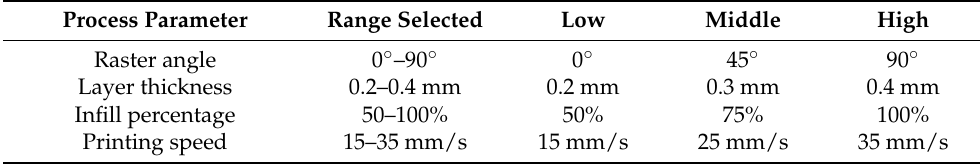
Table 8. Process parameters range used for PETG material along with the related settings